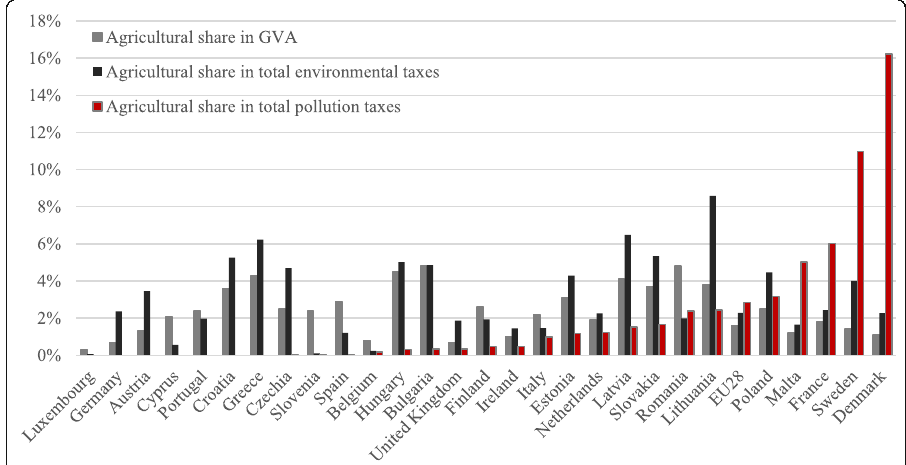
Fig. 4 Share of Agriculture in Total Gross Value Added, Environmental and Pollution Taxes (2015). (Source: Eurostat (2018a). Environmental taxes by economic activity (NACE Rev. 2), Eurostat (2019). Gross value added and income by A*10 industry